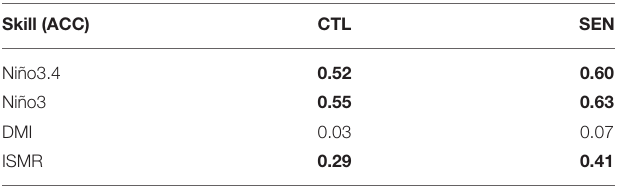
TABLE 3 | Prediction skill represented in terms of anomaly correlation coefficient for ISMR and SST indices for the period 1981–2017. Skill (ACC) CTL SEN Niño3.4 0.52 0.60 Niño3 0.55 0.63 DMI 0.03 0.07 ISMR 0.29 0.41 Correlations significant at 90% confidence level are highlighted as